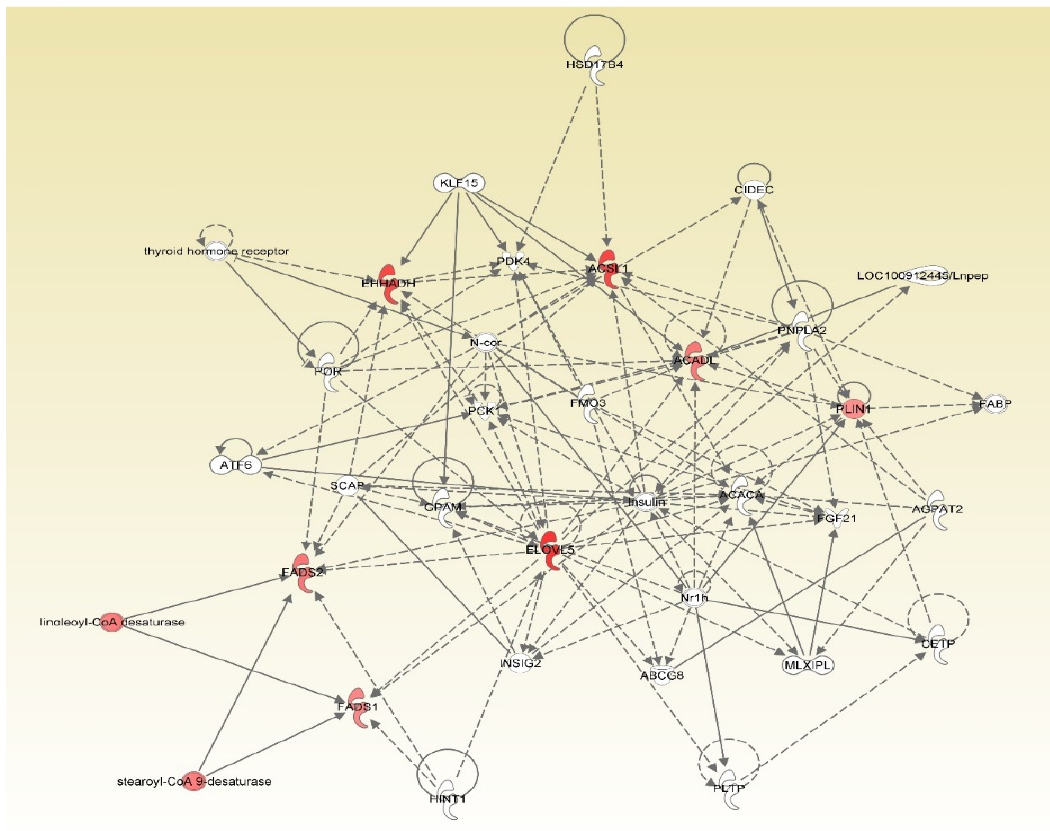
Figure 2. Mechanistic network of the seven fat metabolism genes. The network was generated through the use of IPA (QIAGEN Inc., https://www.qiagenbioinformatics.com/products/ingenuity-pathway-analysis) [27]. These genes include PLIN1 , perilipin 1; FADS1 , fatty acid desaturase 1; FADS2 , fatty acid desaturase 2; ELOVL5 , ELOVL fatty acid elongase 5; ACADL , acyl-CoA dehydrogenase long chain; ACSL1 , acyl-CoA synthetase long-chain family member 1; EHHADH , enoyl-CoA hydratase and